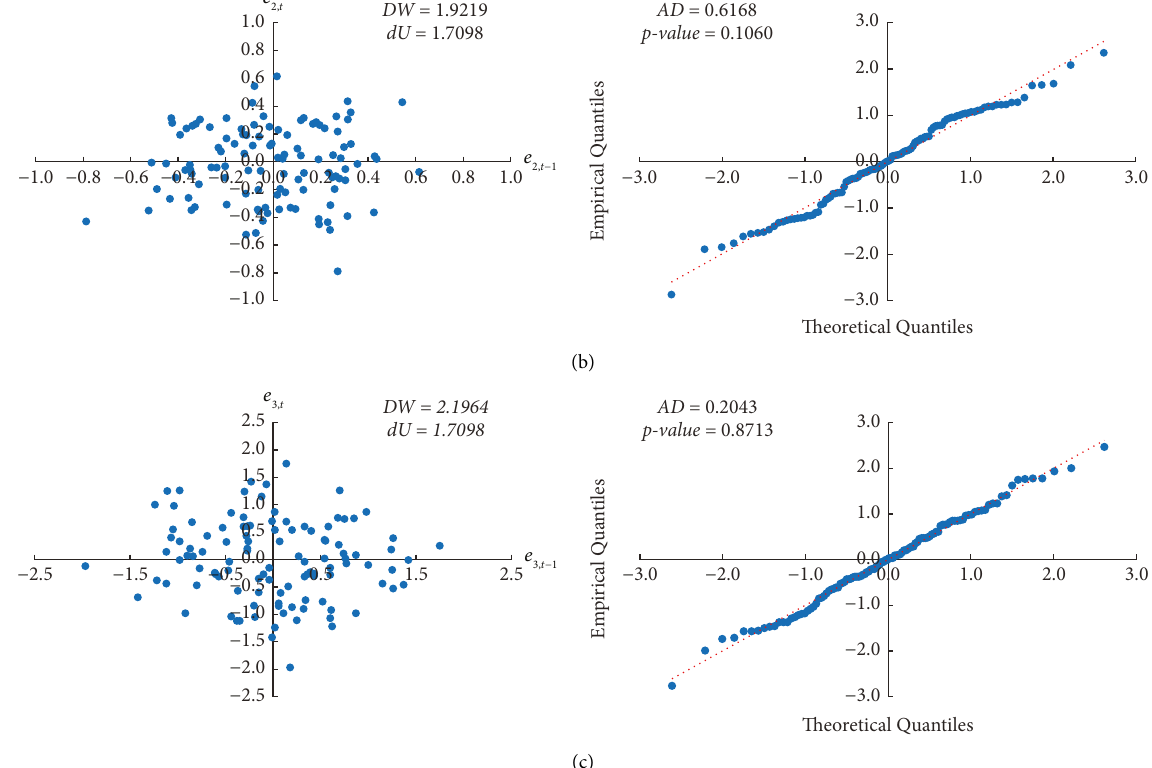
, (b) X , and (c) X 1 2 3